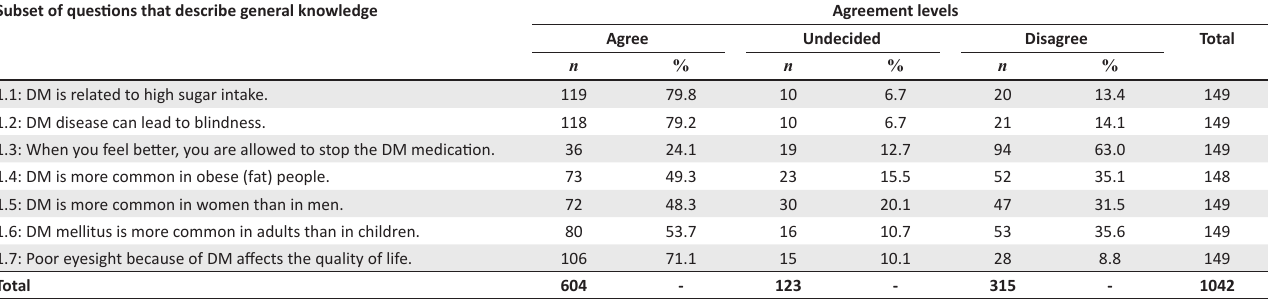
TABLE 1: General health and diabetes mellitus knowledge ( n = 149). Subset of questions that describe general